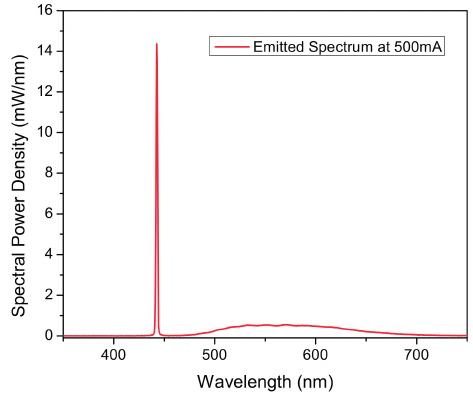
Figure 13. Transmission LARP-emitted output